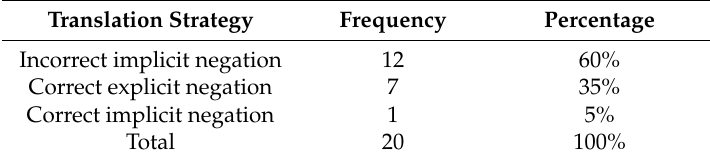
Table 6. Frequency and percentage of translation strategies for few determiner